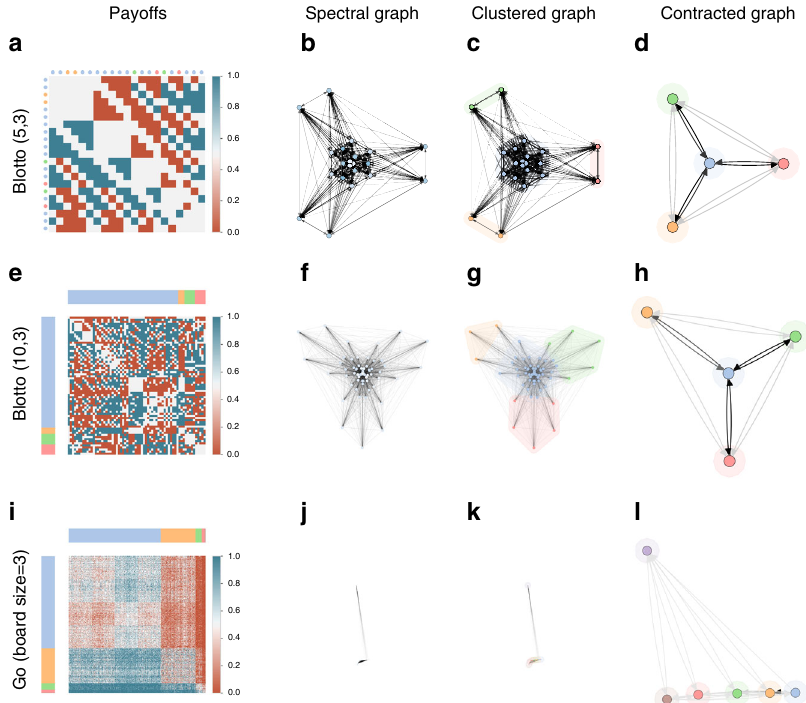
Fig. 8 Results for Blotto(5,3), Blotto(10,3), and Go (board size = 3). Despite the signi fi cant difference in sizes, both instances of Blotto yield a remarkably similar contracted response graph. Moreover, the contracted response graph for Go is notably different from AlphaGo results, due to the latter being an empirical game constructed from trained AI agents rather than a representative set of sampled